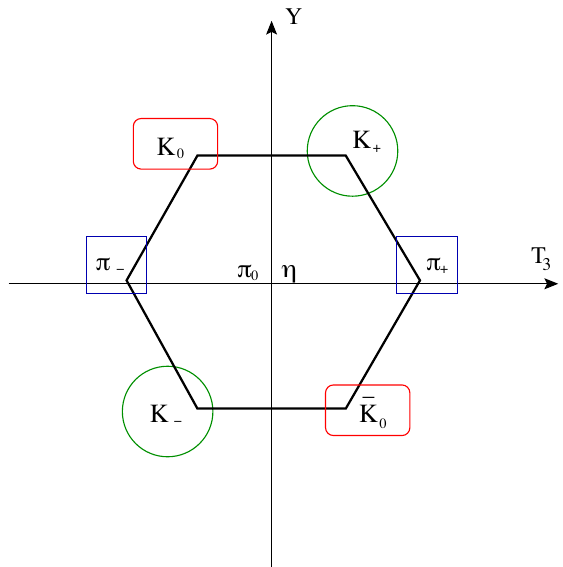
Figure 6. Weight diagram of the mesonic octet. We have enclosed with the same symbol the states that can mix in the meson condensed phase. They have the same T -spin, U -spin and V -spin quantum numbers. The π 0 and the η are not simultaneous T -spin, U -spin and V -spin eigenstates; their mixing depends on the spontaneously induced charge of the vacuum, see [26] for more